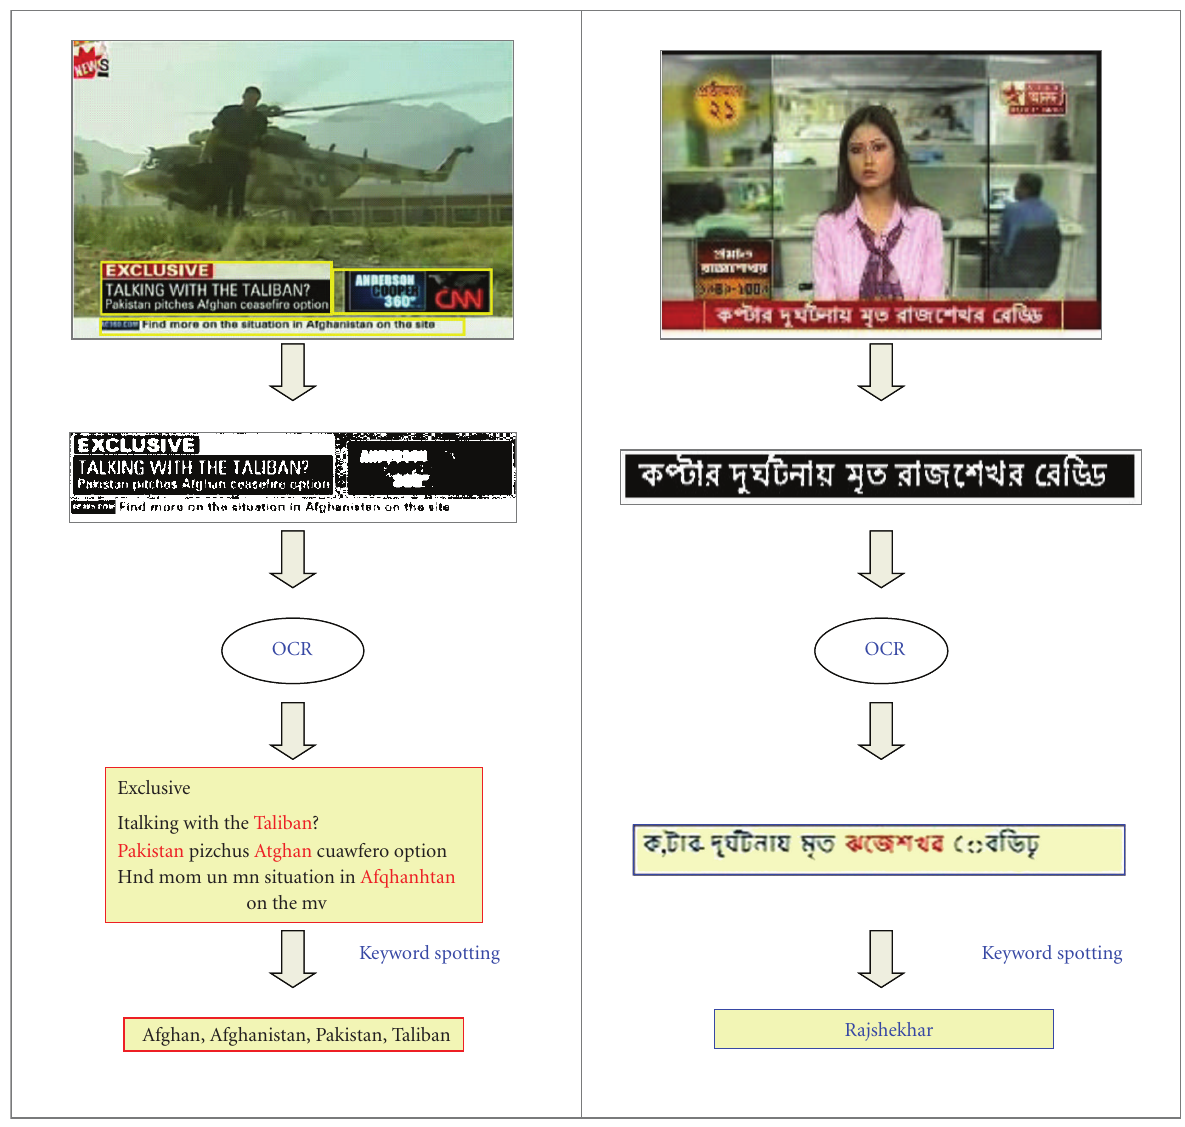
Figure 7: Keyword Identification from English and Bangla news